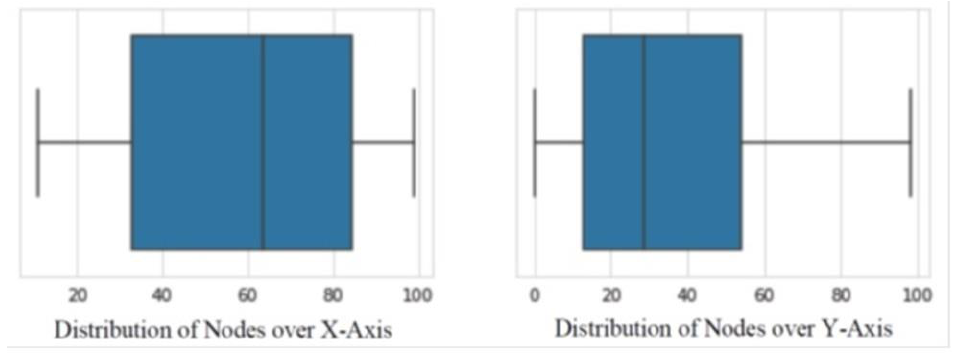
Figure 5. Analysis of data points for outliers using the box plot mechanism .